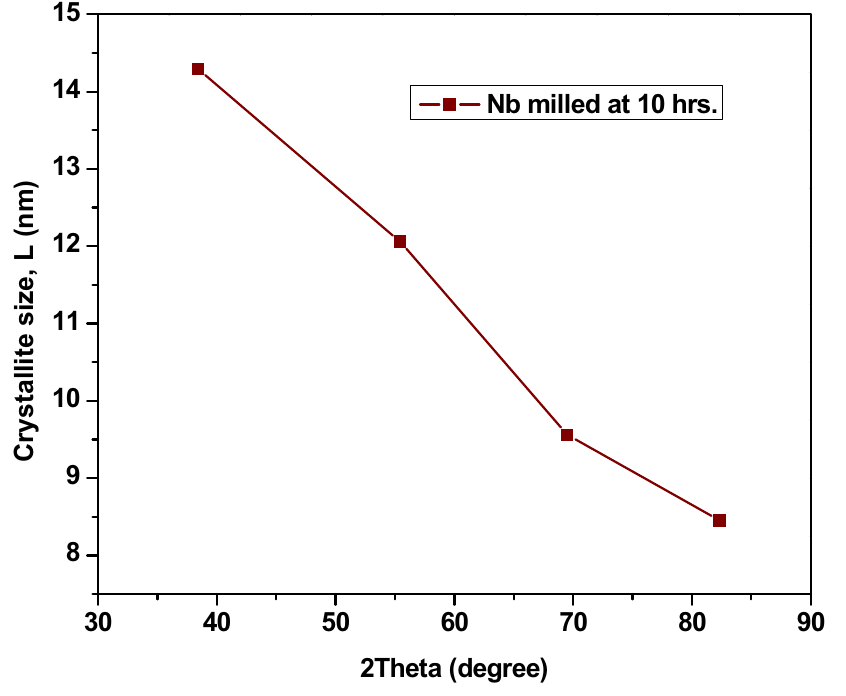
Figure 3. The plot of Crystallites size, L as a function of 2θ.